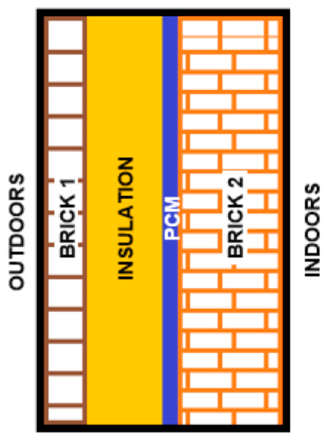
Figure 1. Implementation of passive phase change materials (PCM) in static building envelope.